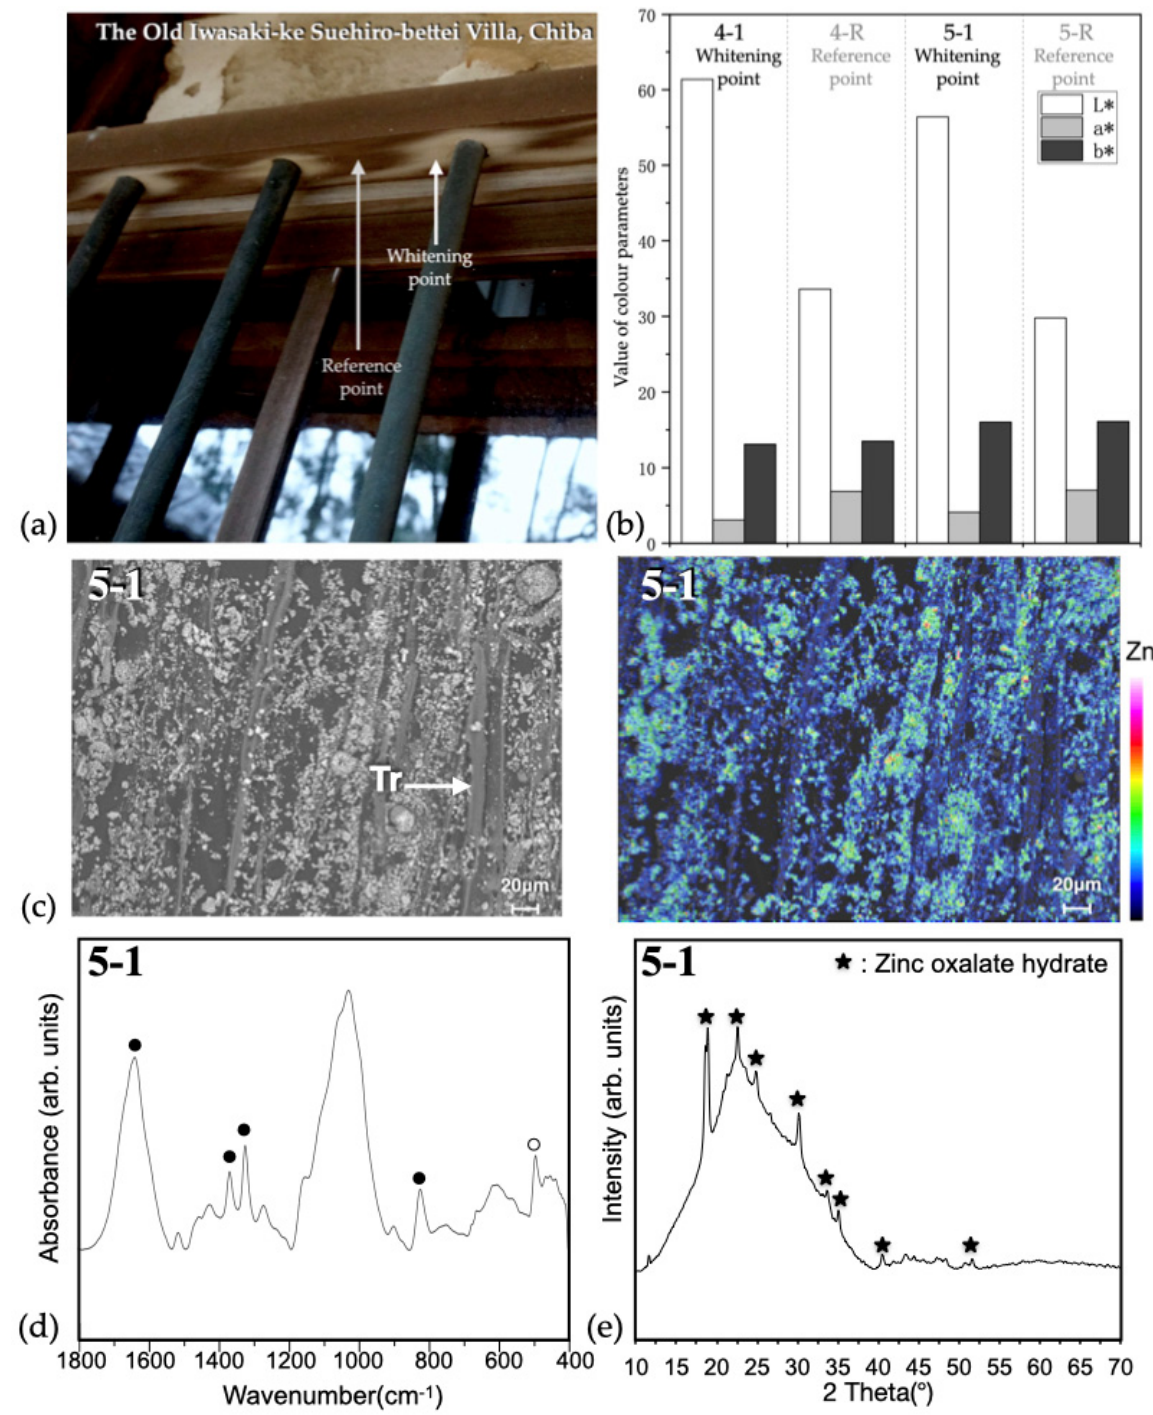
Figure 2. The investigation results of whitening points adjacent to Cu–Zn window bars in the Old Iwasaki-ke Suehiro-bettei. ( a ) The investigated area. ( b ) The colour parameters of the investigated whitening points and the corresponding reference points. The analysis results of the whitening point 5-1: ( c ) the scanning electron microscopy back-scattered electron (SEM-BSE) image, with scattered fine particles among tracheid (Tr) shown to have a significant Zn content; ( d ) the Fourier-transform infrared (FTIR) spectrum, shown with C 2 O 4 -related bands ( • : 1630, 1363, 1317 and 822 cm − 1 ) and Zn–O-related bands ( : 510–400 cm − 1 ); ( e ) the XRD spectrum, shown with the characteristic peaks (cid:35) of zinc oxalate hydrate. Reproduced with permission from ref. [2]. 2021 Taylor &